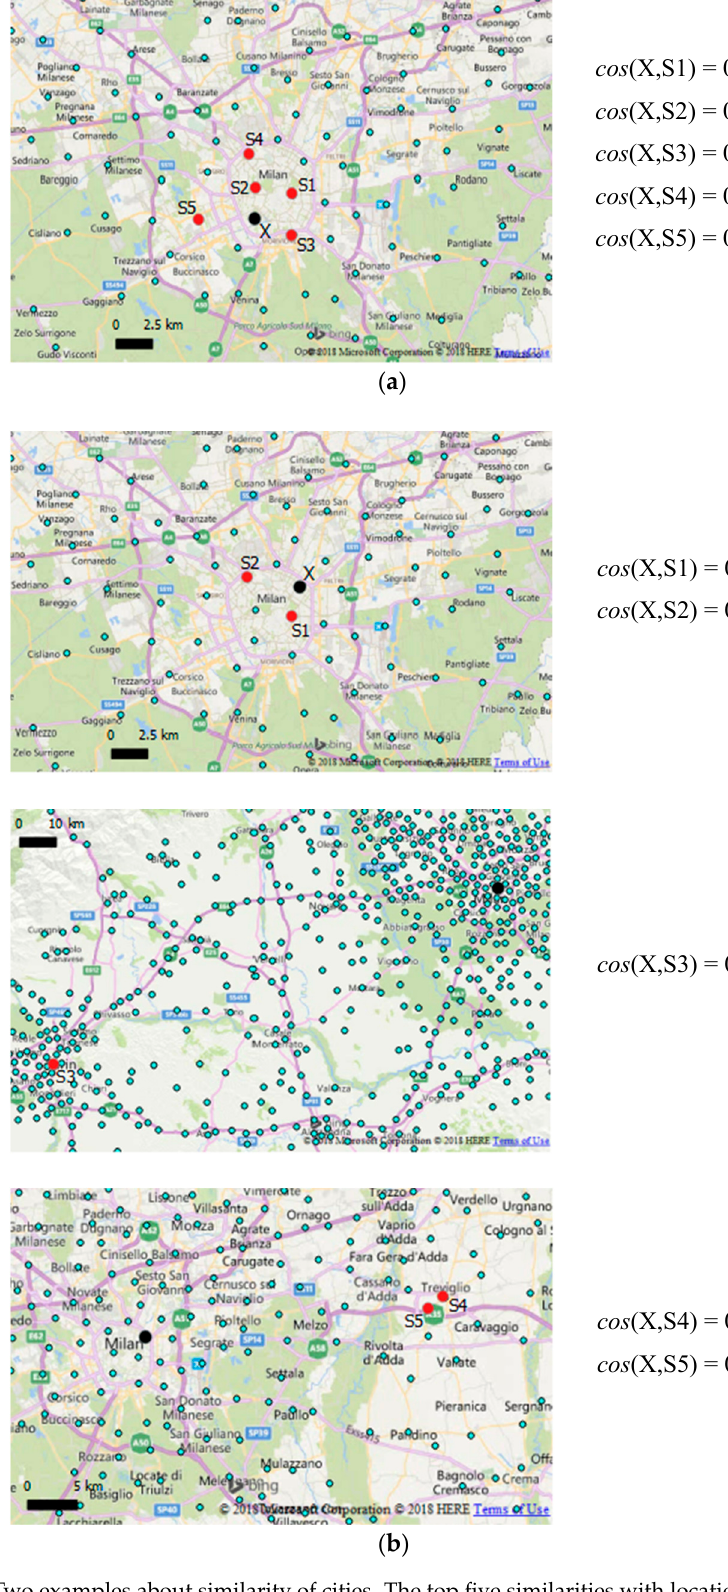
Figure 9. Two examples about similarity of cities. The top five similarities with location X are reported, in case X represents a generic location in the city ( a ), and in case X represents the main train station of the city ( b ). Top similarity values are lower than in Figure 8. Moreover, the train station has three out of the top five similarities related to other train stations outside the city.